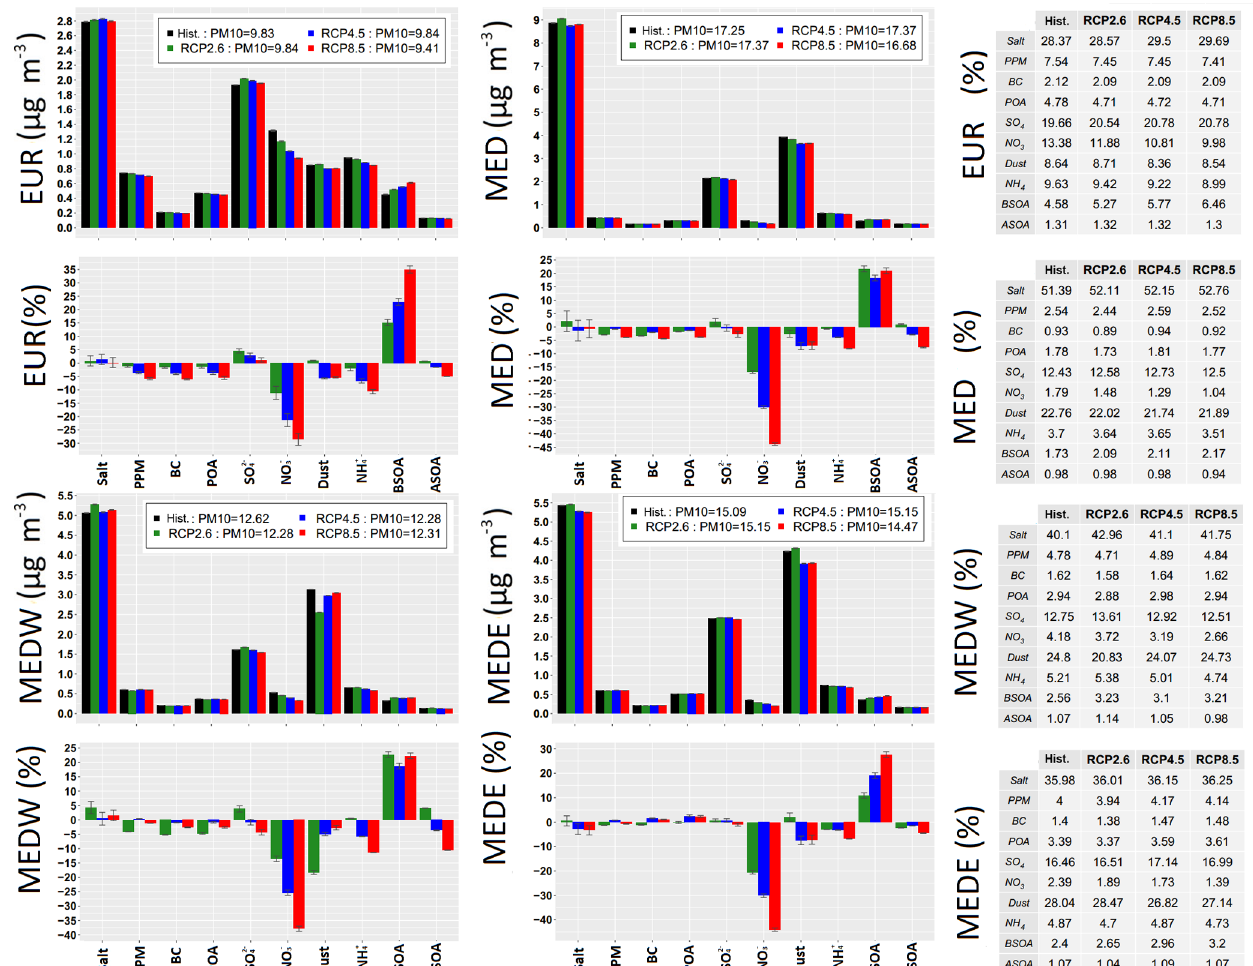
Figure 7. Concentrations and relative changes of PM 10 components (same color code as in Fig. 6) for all subdomains averaged over the whole period of simulations in climate change scenarios and for the different subdomains. Error bars show the confidence interval calculated for the annual averages for each subdomain. The changes show (future − historic) / historic · 100. Tables report the percentage of each component in each scenario. The concentration of PM 10 in total is noted in the legend above each